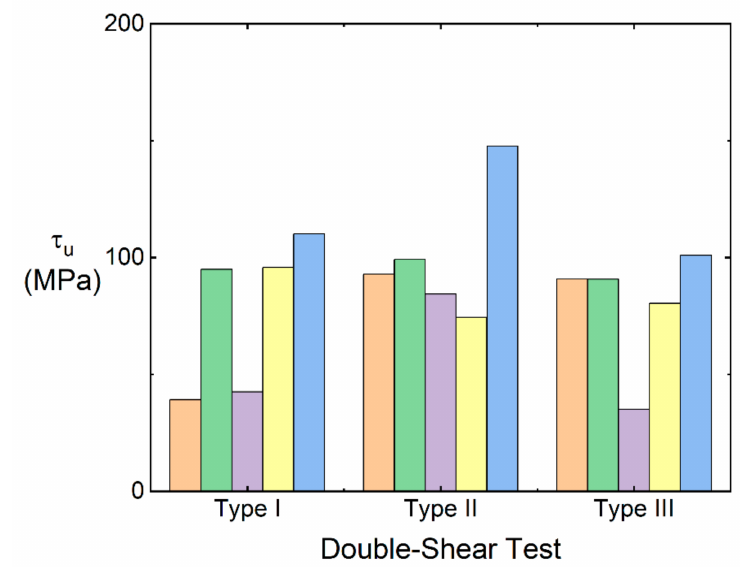
Figure 7. Double-shear strength of the 12k T-700 TM MWK–N–C/SiC pins. Table 3 lists the double-shear mechanical